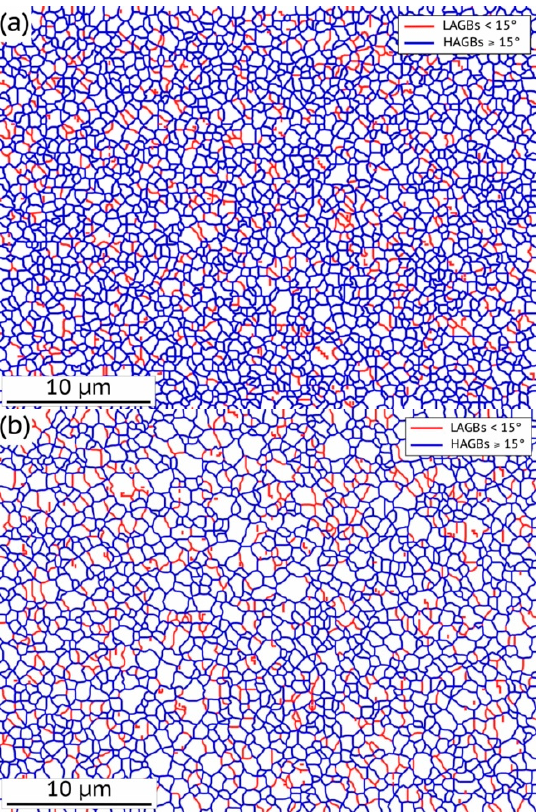
Figure 1. HAGBs (blue lines) and LAGBs (red lines) manifestation in the microstructure of the Al– 0.4Zr alloy subjected to HPT ( a ) and to subsequent annealing ( b